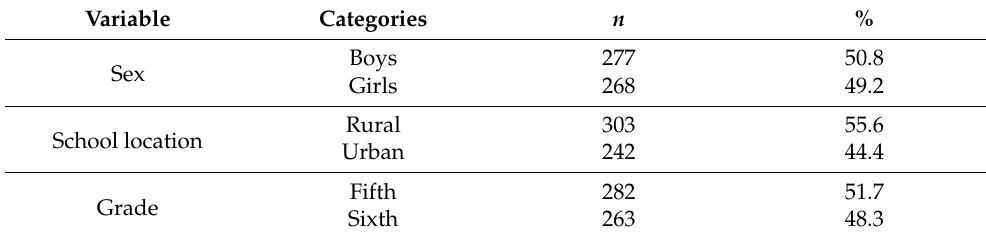
Table 1. Sociodemographic characteristics of the sample ( n = 545). Variable